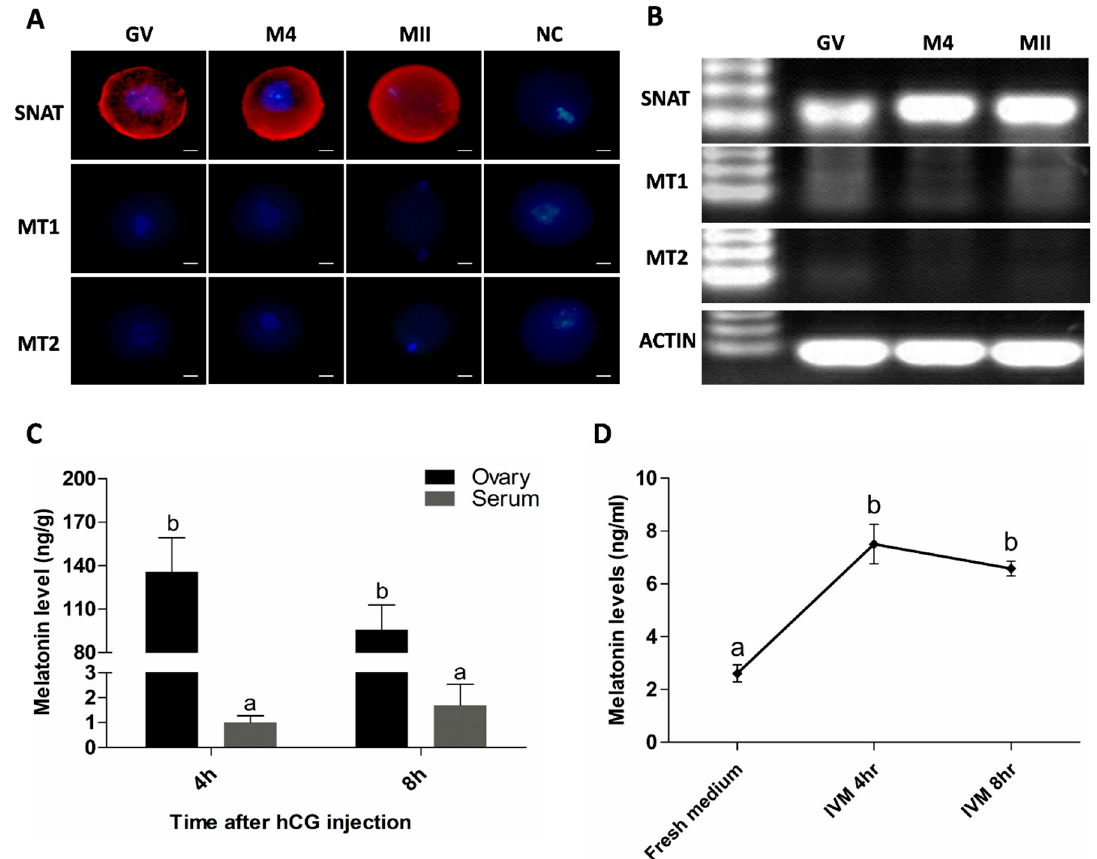
Figure 1. Oocyte synthesis melatonin during its maturation. ( A ) Assayed with immunofluorescence. Red was SNAT staining. Scale bar = 20 μ m; ( B ) Assayed with RT-PCR. GV: Germinal Vesicle Stage, M4: 4 h after hCG injection, MII; Metaphase II of Meiosis, NC: Negative Control; ( C ) Melatonin levels in ovary homogenate and serum of the animals after hCG injection (mean ± SEM); ( D ) Melatonin levels in IVM medium during oocyte culture (mean ± SEM); the different superscript letters (a–b) represent a significant difference ( p < 0.05).